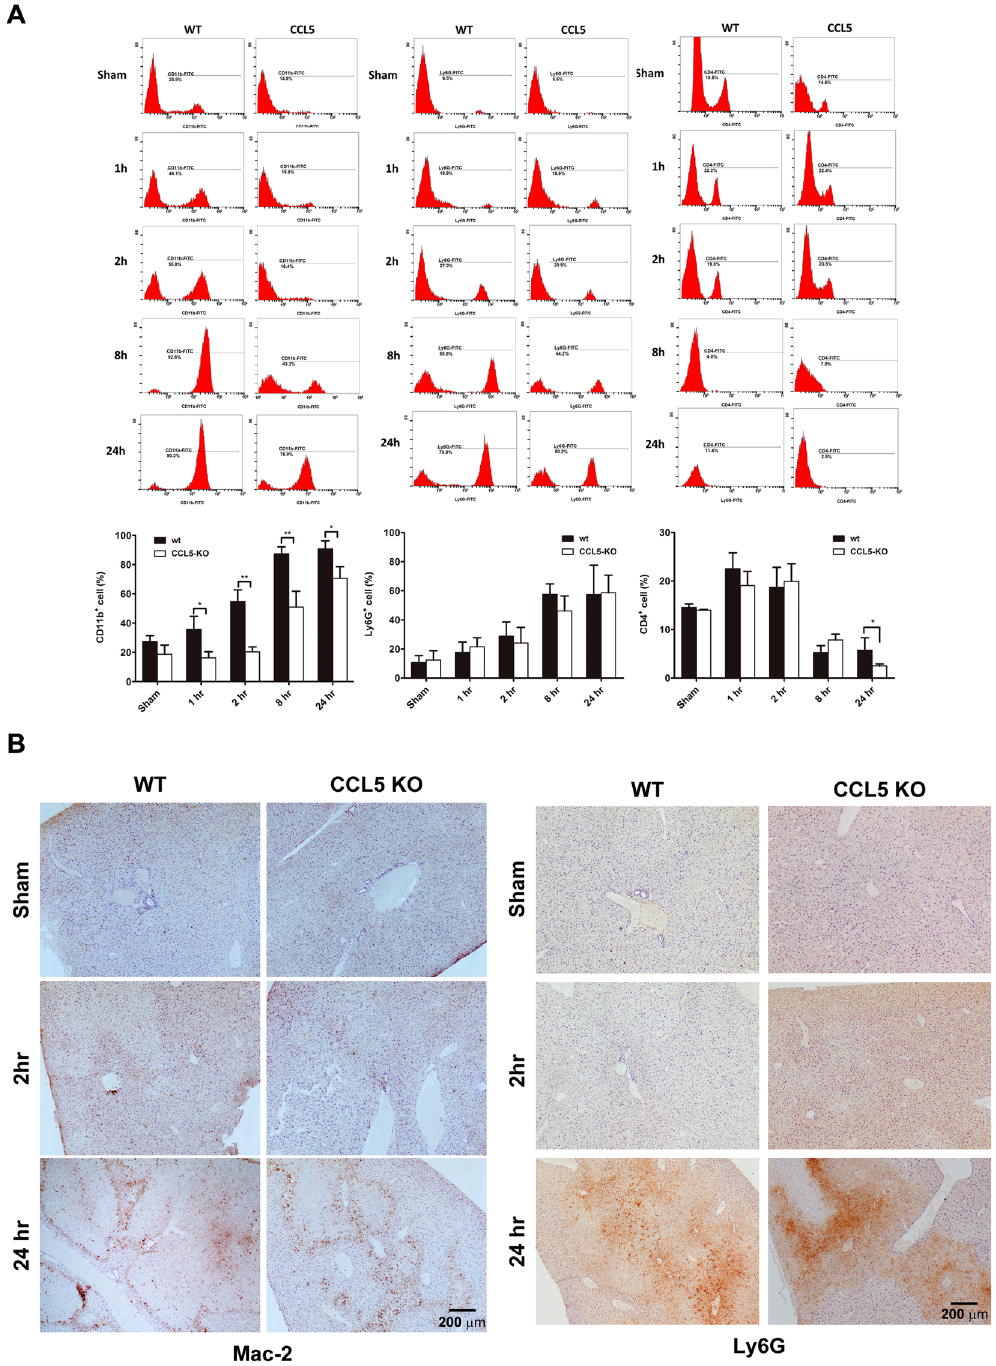
Figure 7. Assessment of intrahepatic leukocyte subsets by flow cytometry. Intrahepatic leukocytes fractions were isolated from mice subjected to 1 hr ischemia and different reperfusion length (wt, and CCL5-KO mice), and recruiting leukocytes were analyzed by flow cytometry. ( A ) The flow cytometry histograms are representative of at least three independent experiments. Numbers indicate the population percentages of CD11b + , Ly6G + , and CD4 + cells in each histogram. Population percentages of CD11b + , Ly6G + , and CD4 + cells from the results of flow cytometric analysis were plotted against respective lengths of reperfusion. Mean ± SD, n = 4–7. * p < 0.05; ** p < 0.01. ( B ) Immunohistochemistry of Mac-2 + and Ly6G + cells as a function of reperfusion time. Scale bar = 200 μ